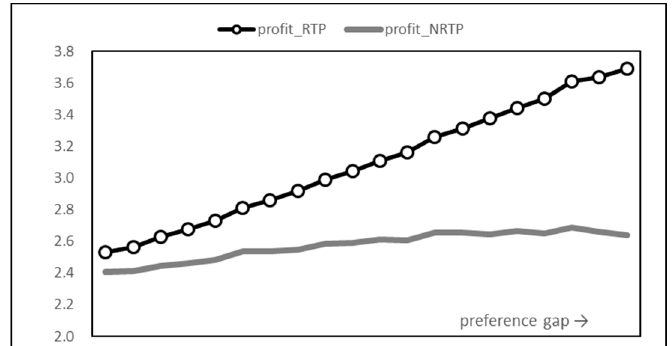
Figure 15. Supplier profit graph.